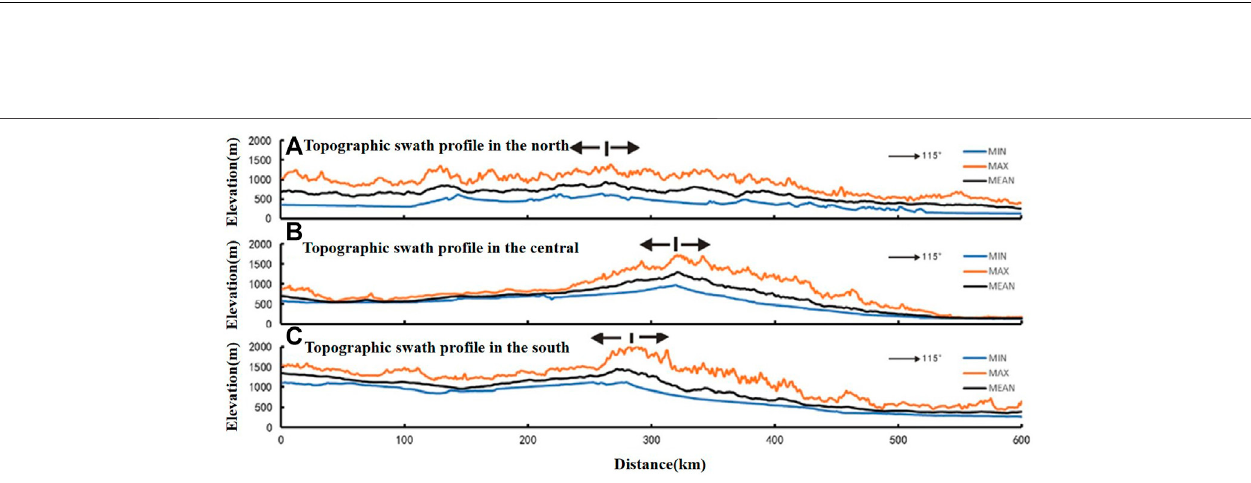
Frontiers in Earth Science |